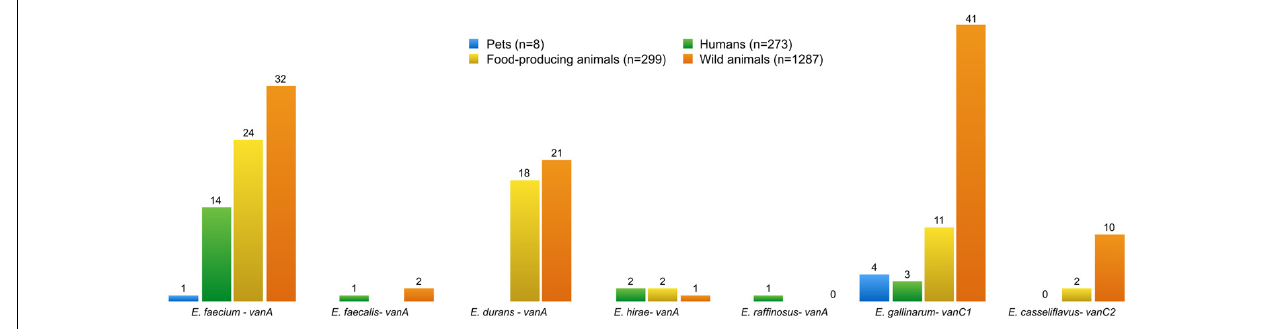
FIGURE 8 | Number of vancomycin-resistant enterococci species, and resistance genes present in all isolates from different groups. E. gallinarum and E. casseliflavus are intrinsically resistant to vancomycin, and harbor the genes vanC1 and vanC2, respectively, in their genome.